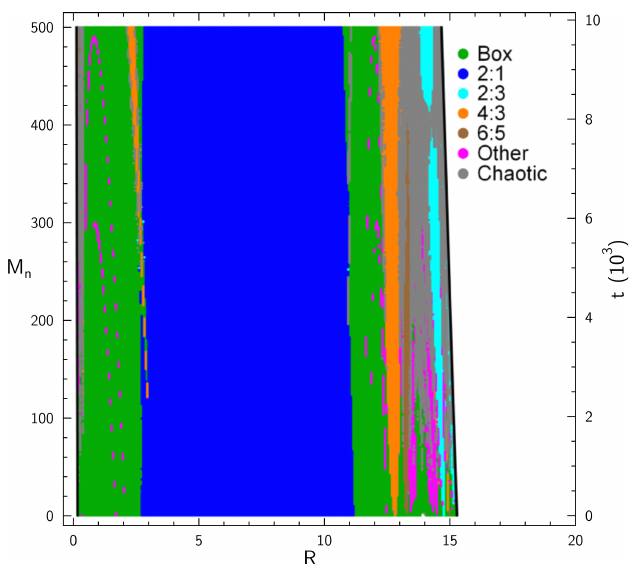
Fig. 8. Orbital structure of the ( R; M n )-plane. This diagram gives us a detailed analysis of the evolution of orbits starting perpendicularly to the R -axis when the mass of the nucleus varies in the interval M n 2 [0 ; 500] during the galactic evolution for 0 (cid:20) t (cid:20) 10000 time units. Fig. 7b where 3500 ≤ t < 3700 we observe that the path of the trajectory the